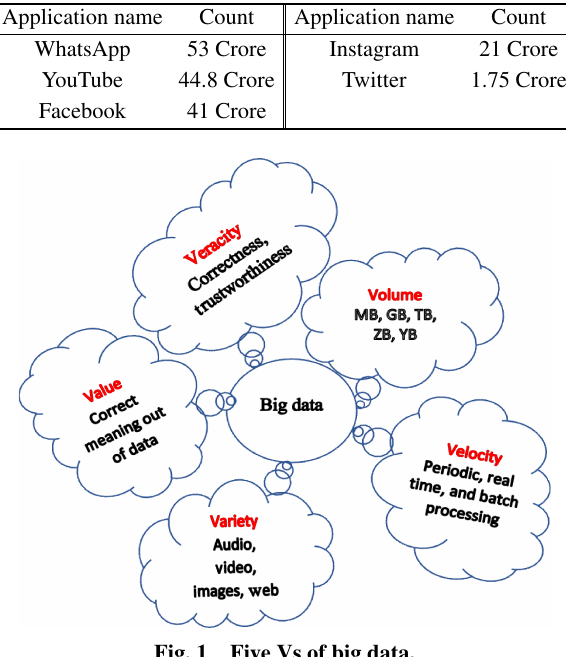
Table 3 Users in India as of February 2021.